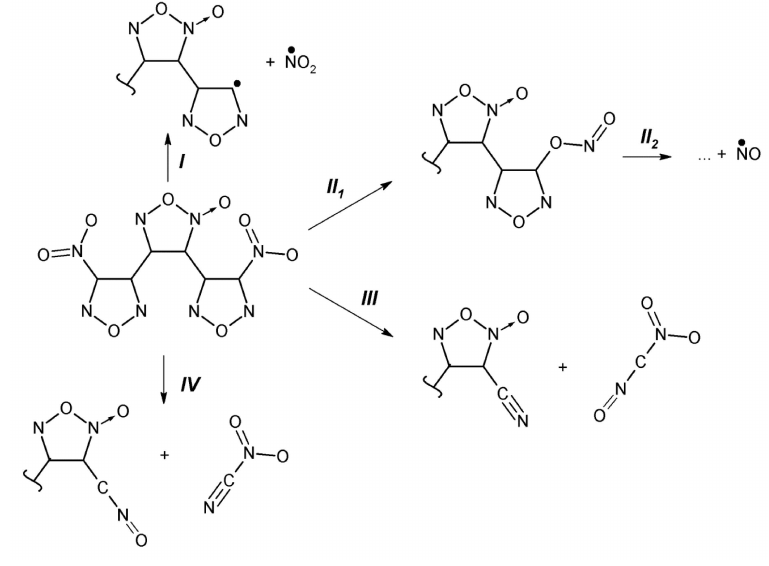
Figure 15. Schematic representation of BNFF